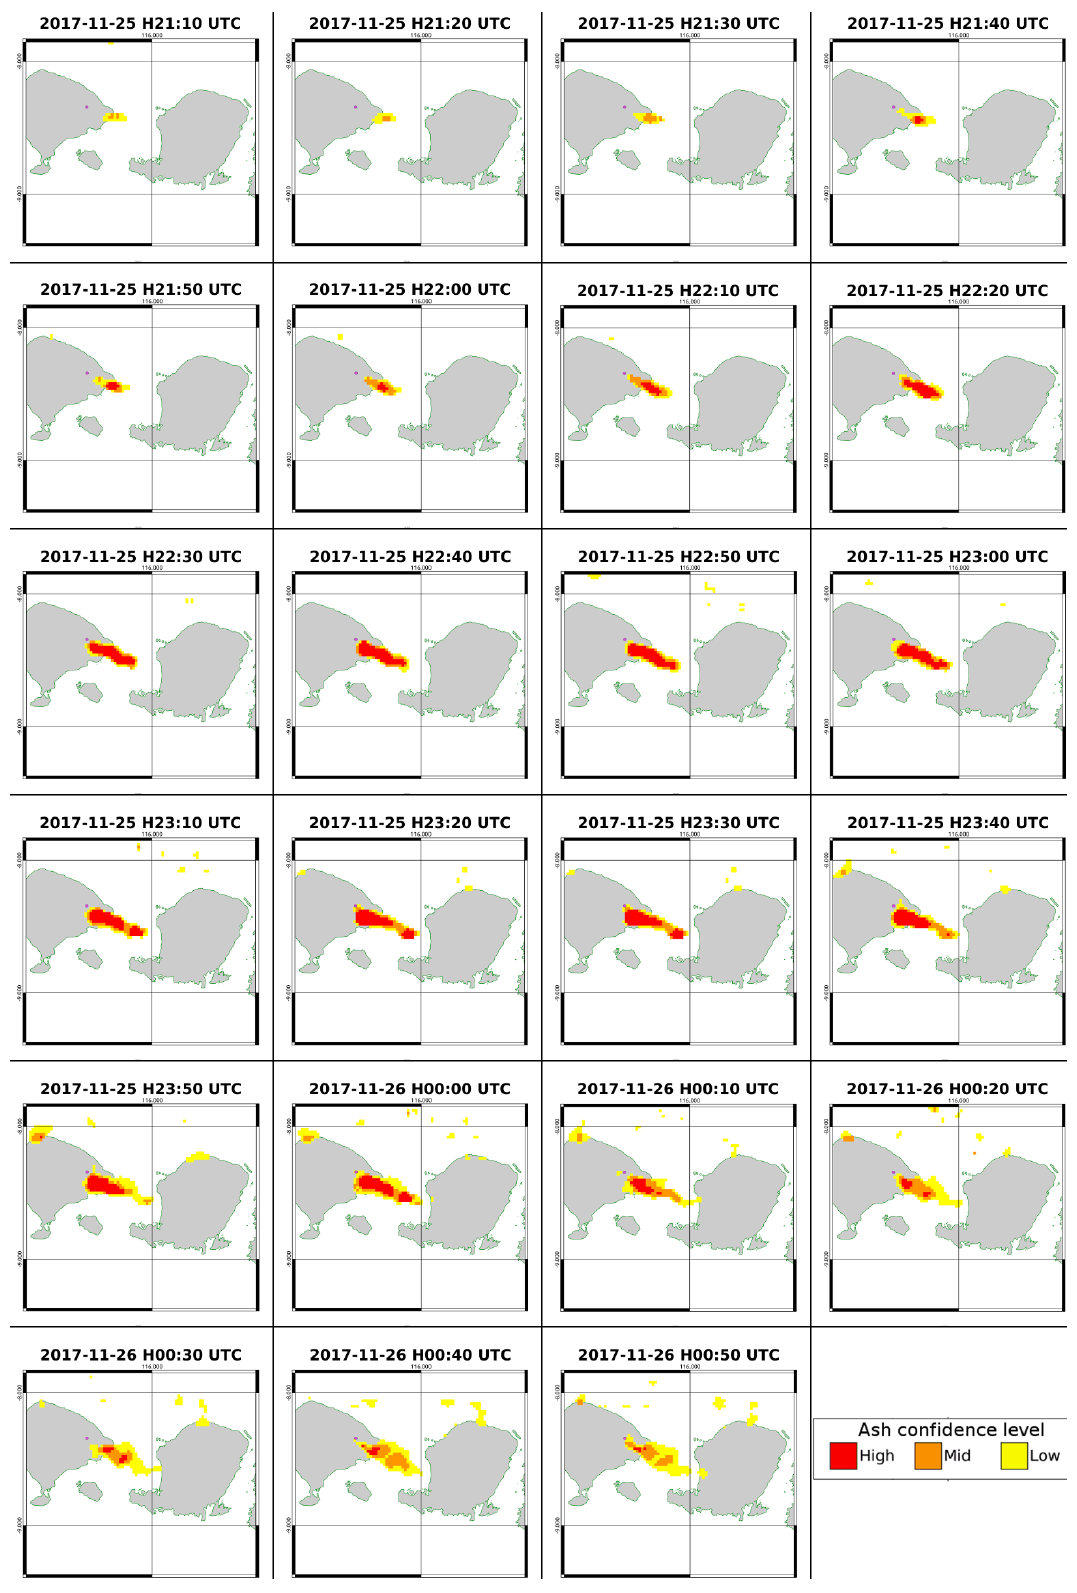
Figure 5. RST ASH maps (at 10 min temporal resolution) generated from infrared Himawari-8 data of 25 November at 21:10 UTC – 26 November at 00:50 UTC. Therefore, even if RST ASH was less effective in detecting ash when eruption was probably at the early stage and the plume was presumably nearly opaque (i.e., during the initial monitoring phase),